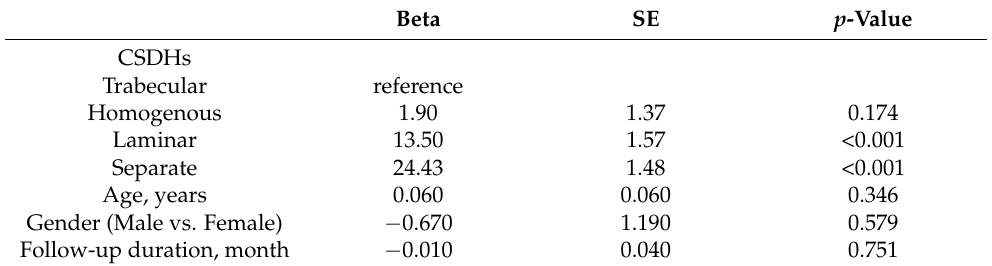
Table 3. The MHD among 4 types of CSDHs adjusted for age, sex, and follow-up duration. Beta